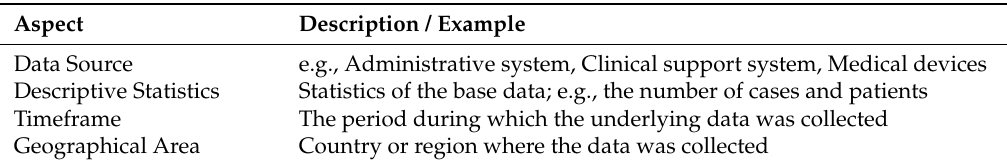
Table A1. Aspects that describe the basic characteristics of the data.